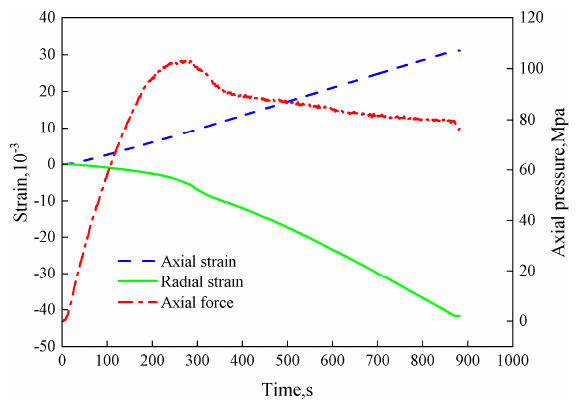
Figure 7. Typical core stress and strain time change curve.